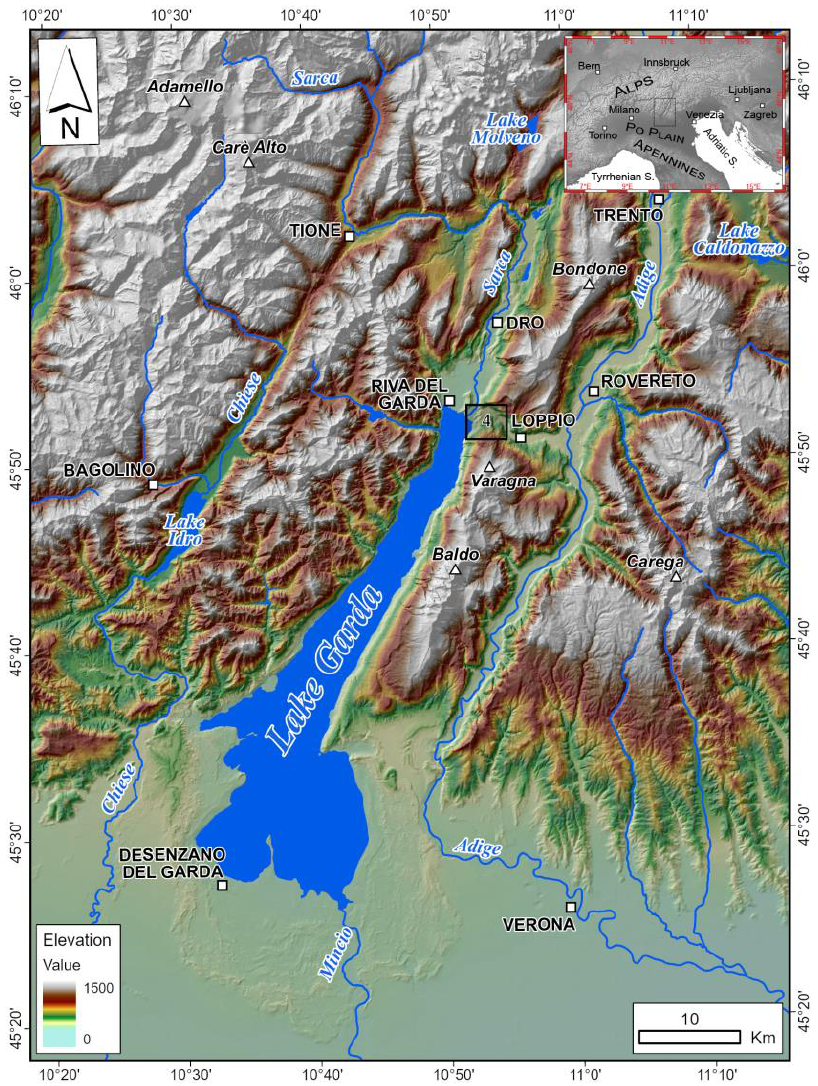
Figure 1. Geographical overview of the Alpine sector where the study area is. The major cities, peaks, rivers and lakes are shown, together with the location of Figure 4. The background was obtained from the Italian SRTM derived digital elevation model (25 m cells).